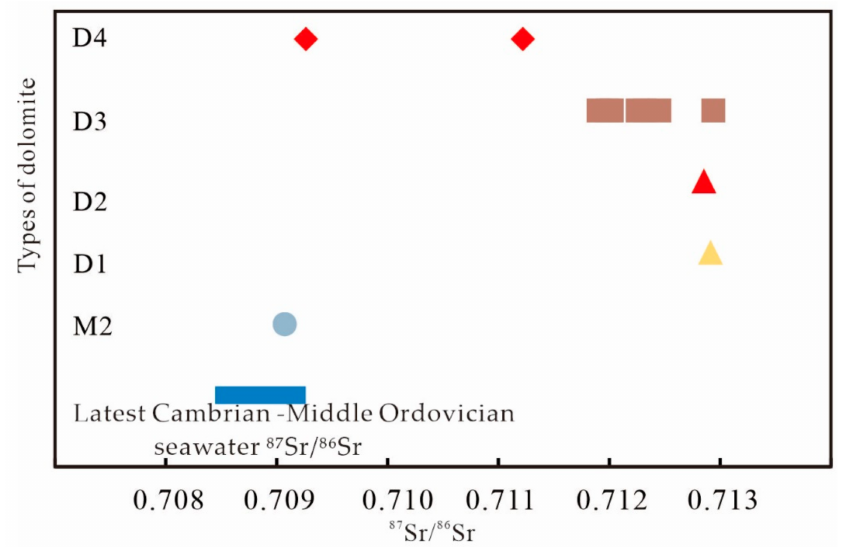
Figure 8. Comparison of radiogenic strontium isotope ratios between Lower Paleozoic dolomite and Latest Cambrian to Middle Ordovician seawater. The 87 Sr/ 86 Sr ratios of Latest Cambrian to Middle Ordovician seawater from [56,57]. M2: microcrystalline dolomite; D2: fine-crystalline ferroan dolomite cements; D3: medium-to-coarse-crystalline dolomite cements; D4: saddle